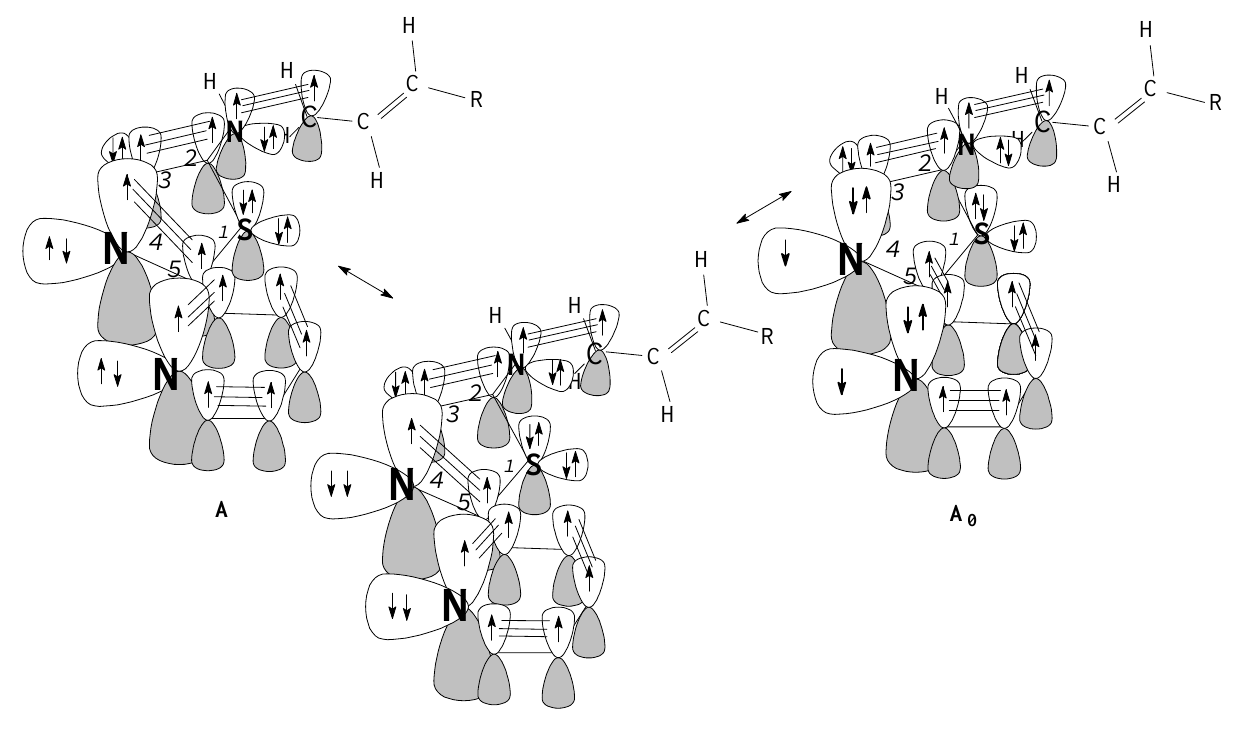
Figure 9. The changes of the electron configuration of N4 N10 nitrogen atoms of allyl- (5-pyridin-2- yl-[1,3,4] thiadiazol-2-yl)-amine, the structure A